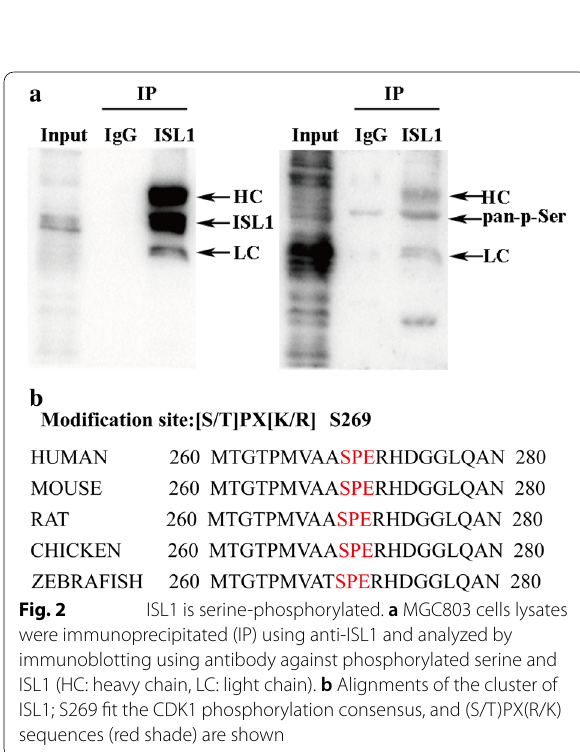
Fig. 2 ISL1 is serine-phosphorylated. a MGC803 cells lysates were immunoprecipitated (IP) using anti-ISL1 and analyzed by immunoblotting using antibody against phosphorylated serine and ISL1 (HC: heavy chain, LC: light chain). b Alignments of the cluster of ISL1; S269 fit the CDK1 phosphorylation consensus, and (S/T)PX(R/K) sequences (red shade) are